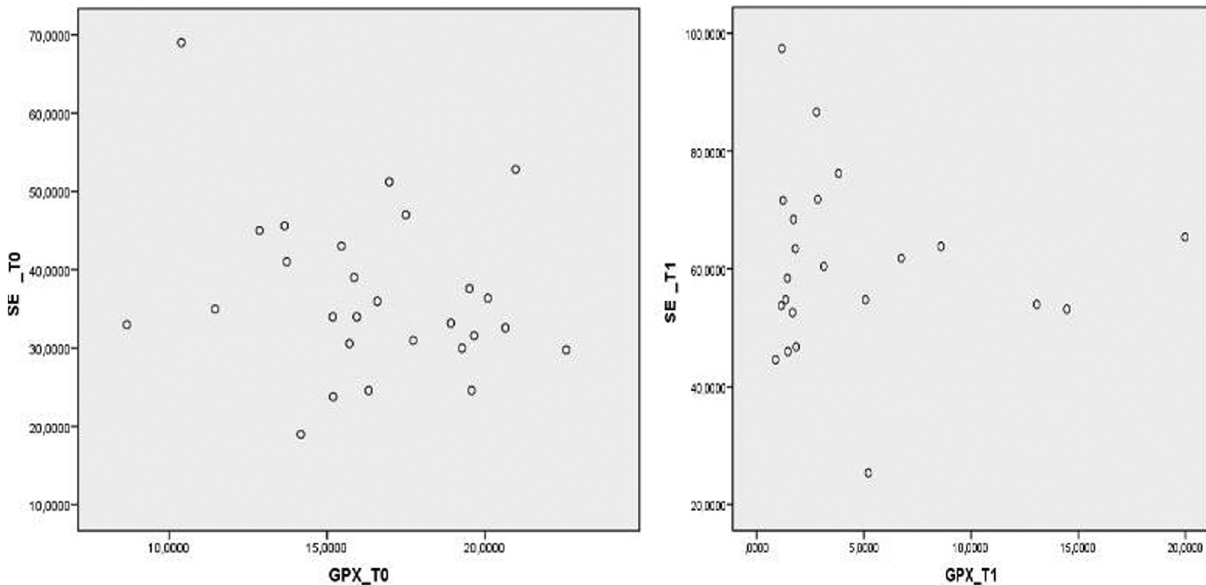
Figure2 -ScatterplotofGPxmeansonT0andT1 . Se_T0:seleniumbeforesupplementation;GPX_T0:glutathioneperoxidase_beforesupplementation. Se_T1: selenium after GPX_T1: glutathione peroxidase_ after